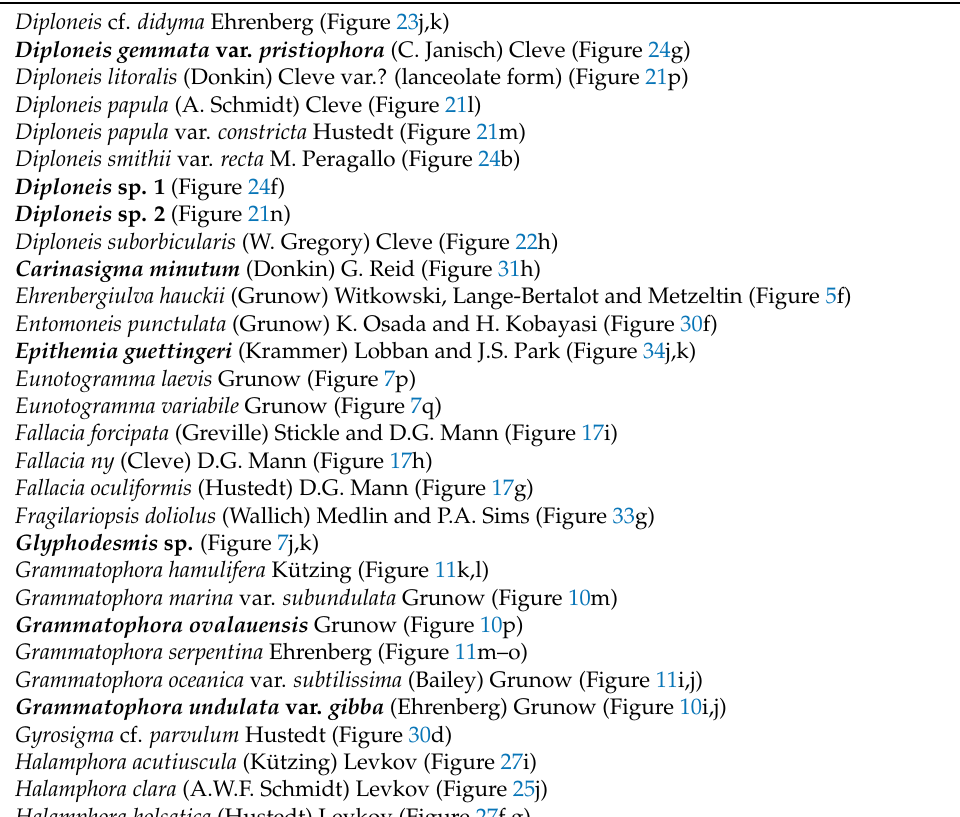
Table 1. Cont. Diploneis cf. didyma Ehrenberg (Figure 23j,k)